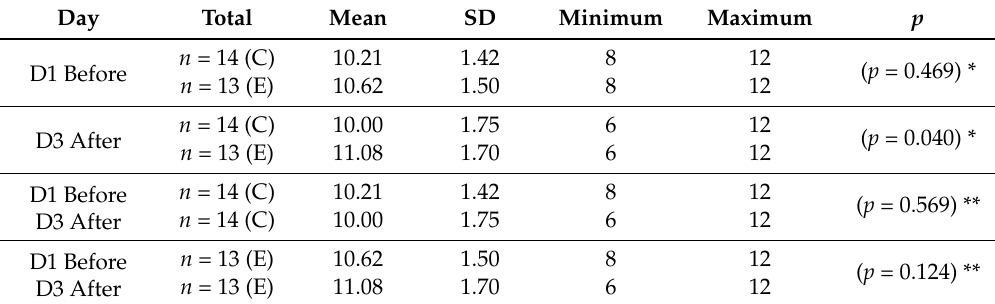
Table 4. Scores on the Hope and Optimism subscale before and after the interventions.